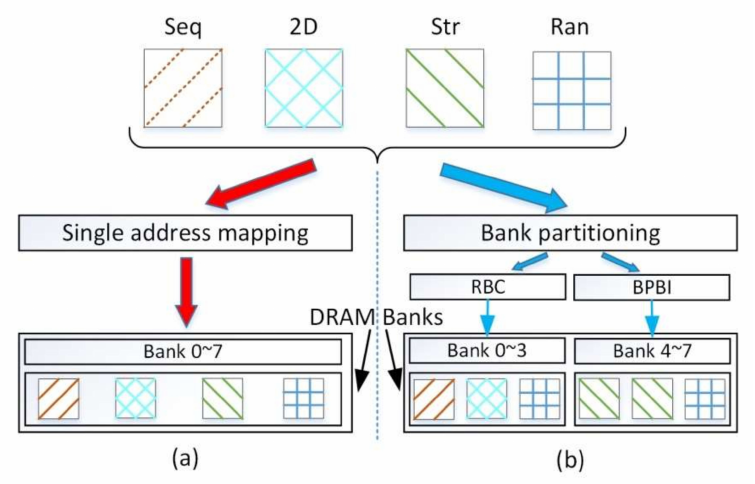
Figure 8. Overview of our proposed bank partitioning model. ( a ) Traditional. ( b ) Our